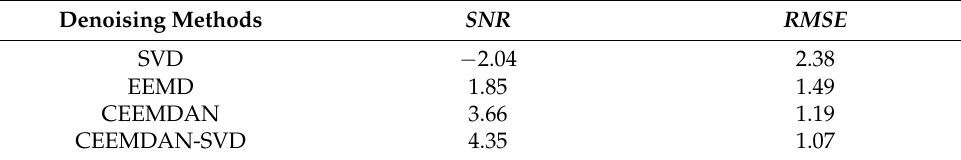
Table 1. Comparison of SNR and RMSE results of four denoising methods. Denoising Methods SNR